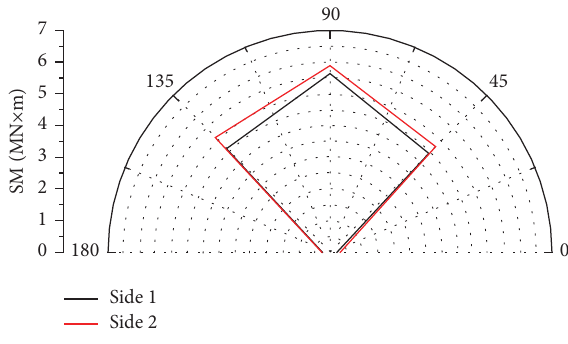
Figure 33: Splitting moment in different